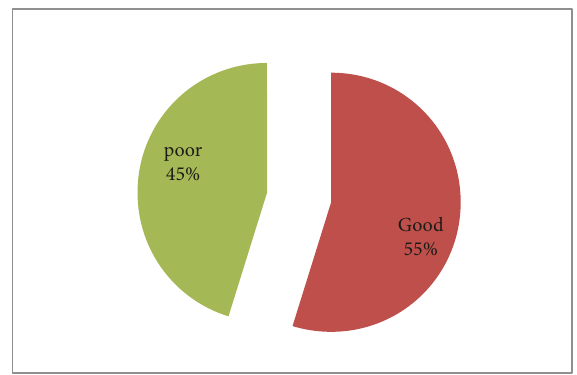
Figure 1: Treatment outcomes of hospitalized stroke patients at Shashemene Referral Hospital, Ethiopia,